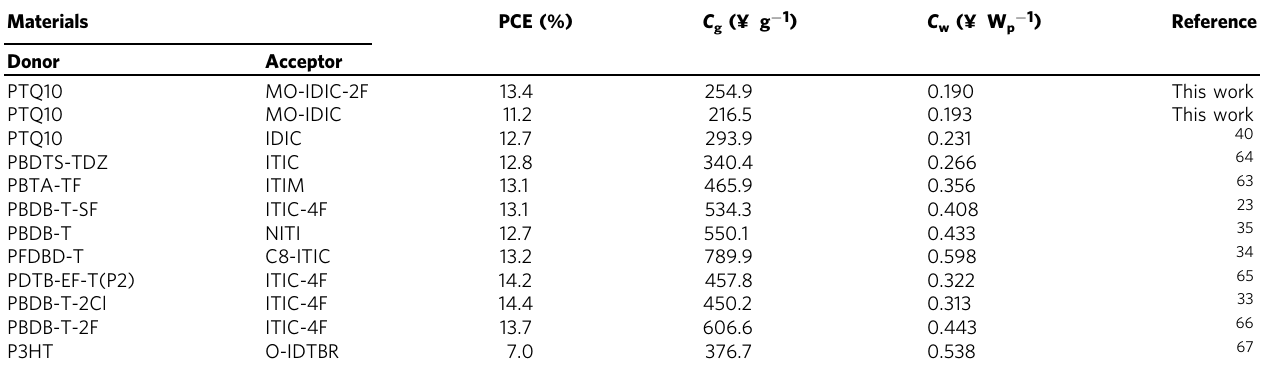
Table 2 Survey of the donor and acceptor materials, as well as the maximum PCE and material costs C g and C w Materials